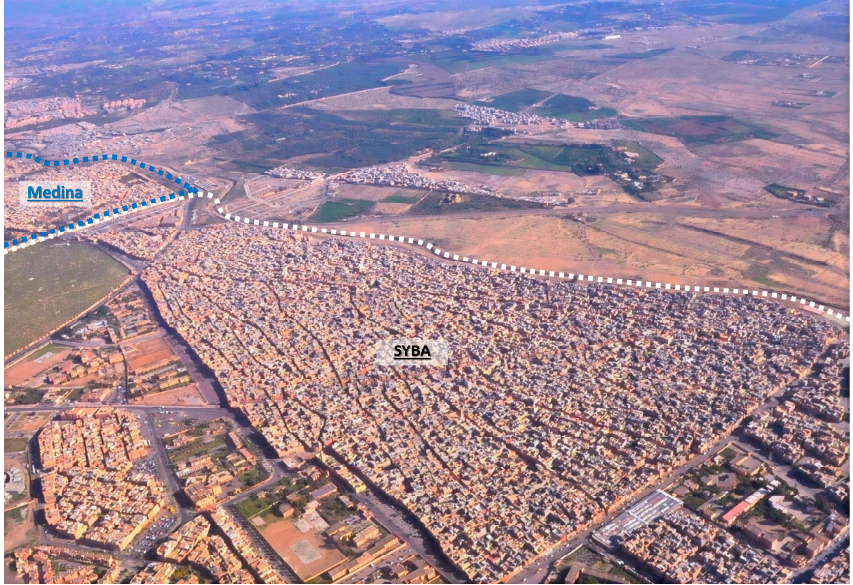
Figure 15. The SYBA and Medina